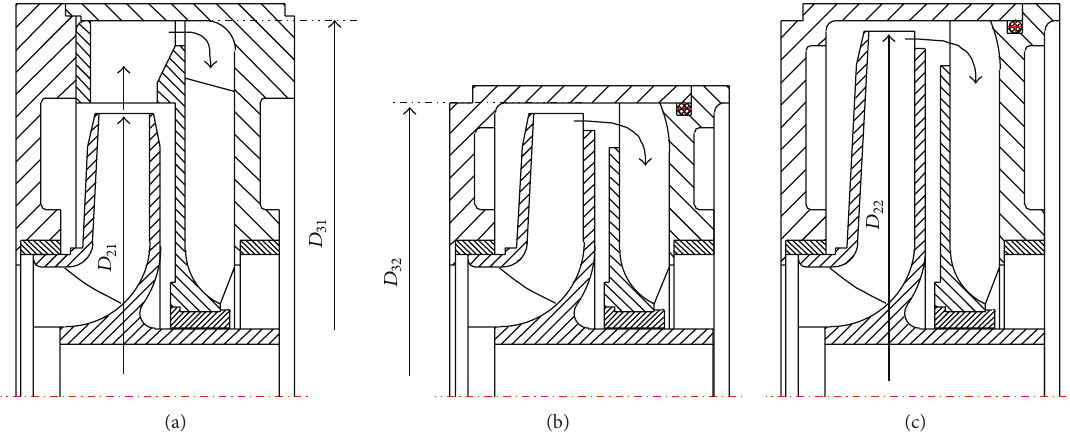
Figure 2: Structure comparison: (a) former structure, (b) special case I, and (c) special case